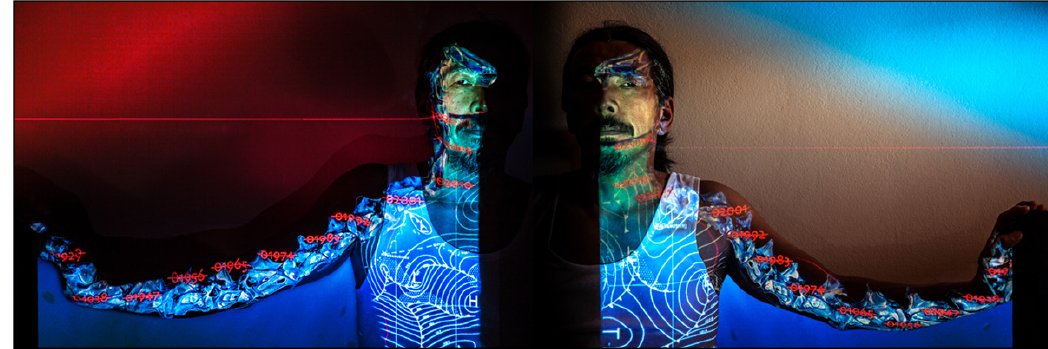
Figure 8. >2 degrees of separation <2028: Akira and <2 degrees of separation <2028: Akira from When I Was A Buoyant in Facing Futures Free From Fear (2013).